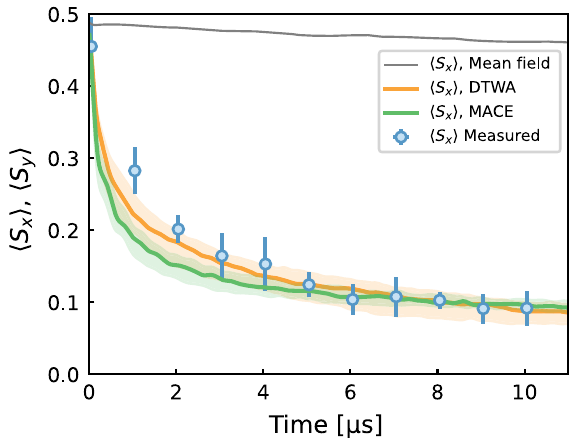
FIG. 9. Comparison between DTWA and MACE. Both moving average cluster expansion (MACE) and DTWA perform well to describe the experimental data at late times. At intermediate times (between 1 and 3 μ s), MACE predicts faster depolarization